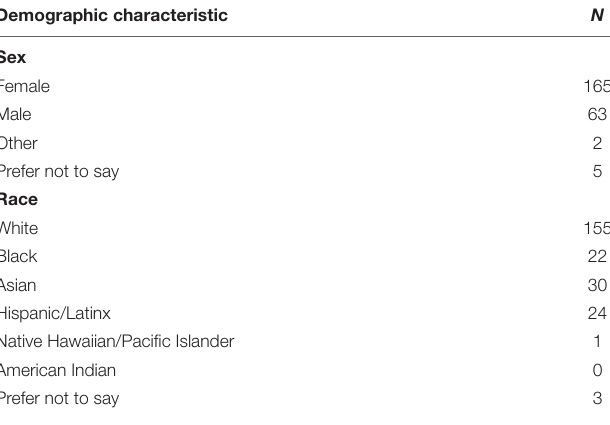
TABLE 1 | Sample demographic